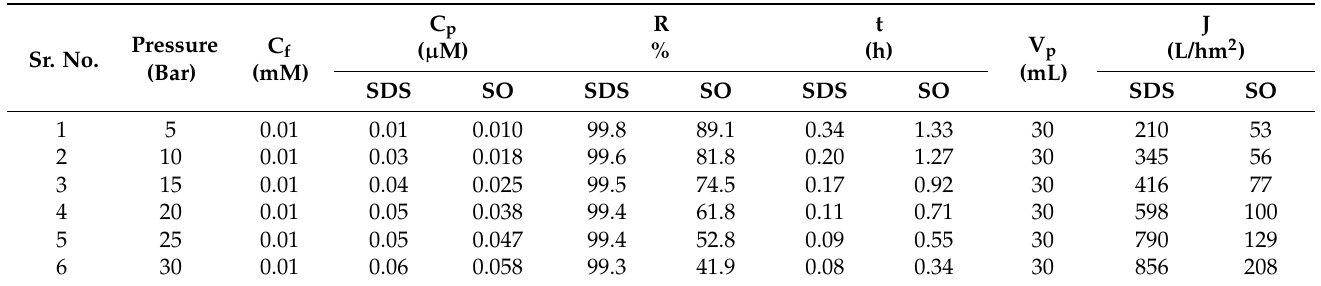
Table 4. Calculation of rejection percentage (R%) and permeate flux (J) of Co 2+ using different values of pressure, in SDS and SO solutions at fixed Co 2+ concentration in feed (C f ), Co 2+ concentration in